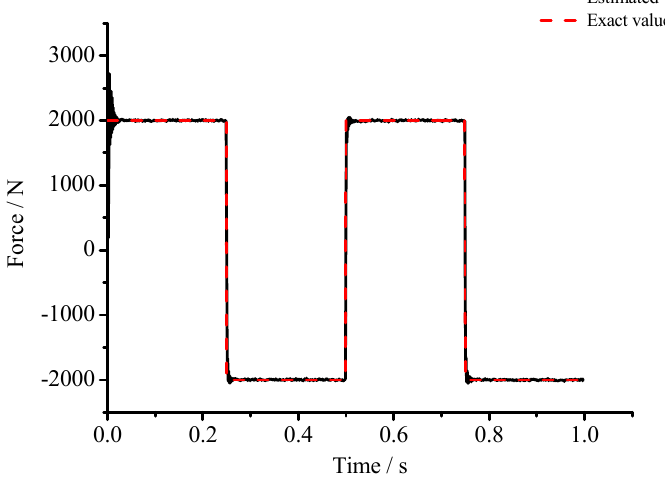
Figure 6. Estimation results of the triangular input force ( Q w = 1 × 10 − 3 , σ = 1 × 10 − 6 ) .